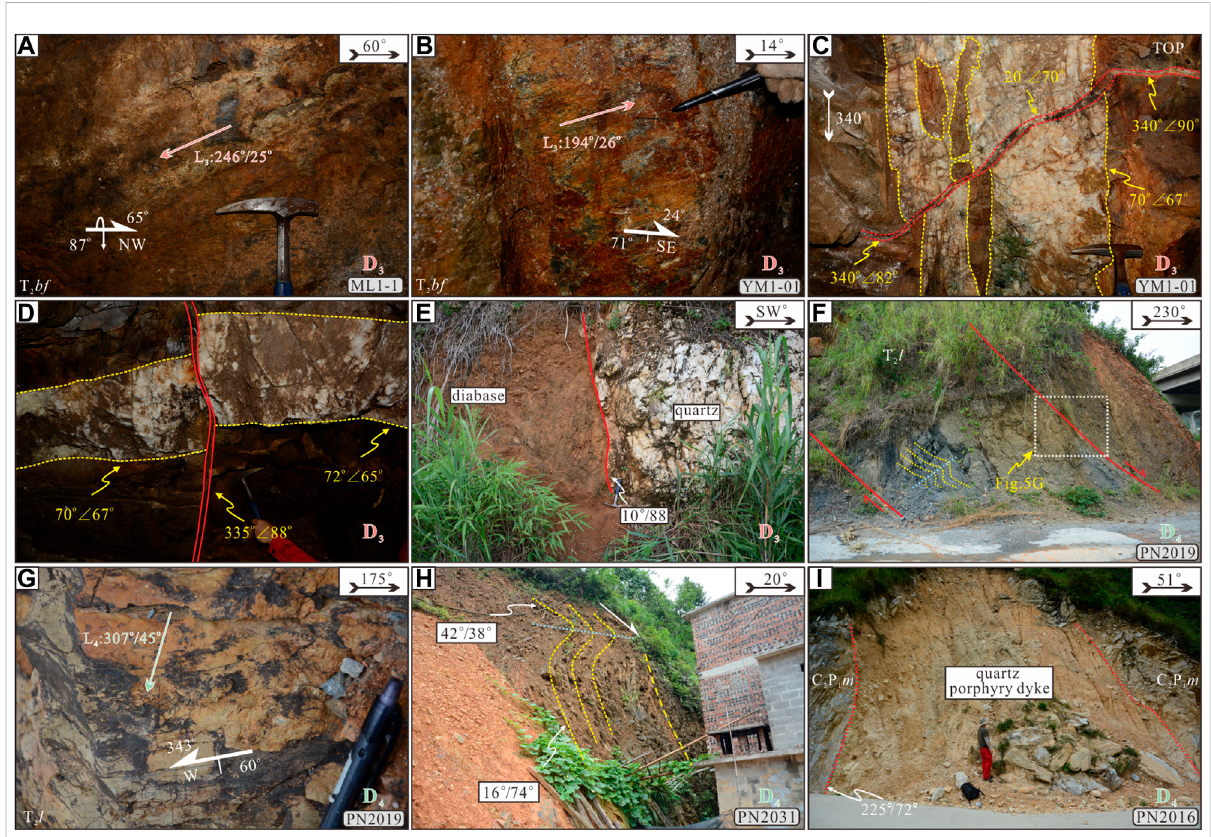
FIGURE 5 Field photographs of main structures and intrusions developed in the D 3 and D 4 structures in the YFTB. (A) Oblique striations on the NE-strike- slip fault plane in the siltstones of the Triassic Baifeng Formation at ML1-1 showing a NW – SE-oriented compression. (B) Strike-slip striations on the NNE-striking fault plane in the siltstones of the Triassic Baifeng Formation at YM1-01 indicating a NW – SE-oriented compression. (C) NW-striking fault crosscut NE-striking fault at YM1-01 in the Pingna underground tunnel. (D) NW-striking fault plane crosscutNE-striking fault in thePingna underground tunnel. (E) NNE-striking fault crosscut the diabase that ourcropped in the Yangxu area. (F) The NW-striking normal fault and drag folds in the mudstones of the Triassic Lanmu Formation at PN2019 indicating nearly E – W-oriented extension. (G) The downward striations in the mudstones of the Triassic Lanmu Formation at PN2019 showing nearly E – W-oriented extension. (H) Asymmetric fold in Triassic siltstone at PN2031 implying the nearly E – W extension. (I) Quartz porphyry dyke intruded along the NW-striking fault. The fault crosscut the limestone of the Carboniferous Maping Formation at